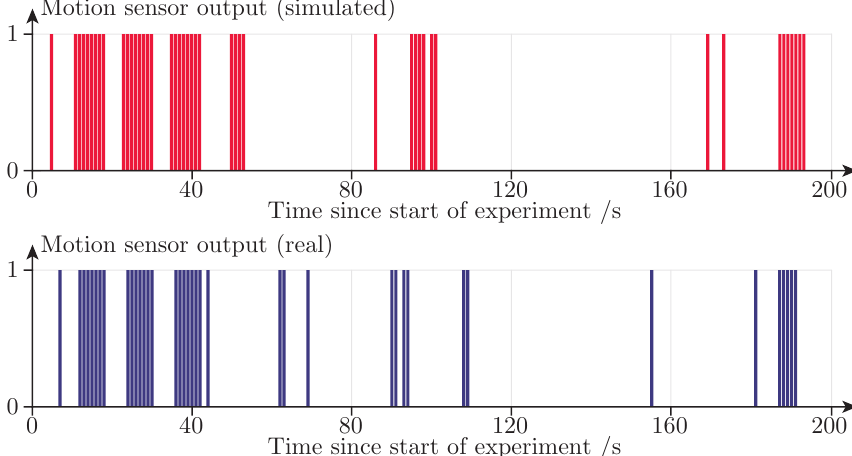
Figure 9. PIR sensor output as a function of time. The upper subplot shows simulated motion sensor data from one of the repetitions of the experiment in Study A. The lower subplot shows the motion sensor data collected during the real-world experiment. Both time series originate from sensor PIR 1 and seat S1. The sum of the simulated series is 45, whereas the sum of the series from the real-world sensor is 39.